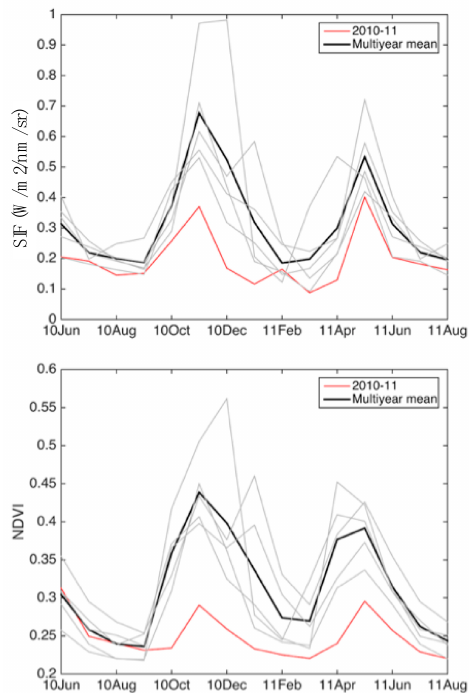
Figure 4. The 2010–2011 drought (red) represented a significant reduction of productivity (SIF and NDVI, Normalized Difference Vegetation Index) as compared to the mean annual cycle (thick black line) of different precipitation products averaged over the drought region.